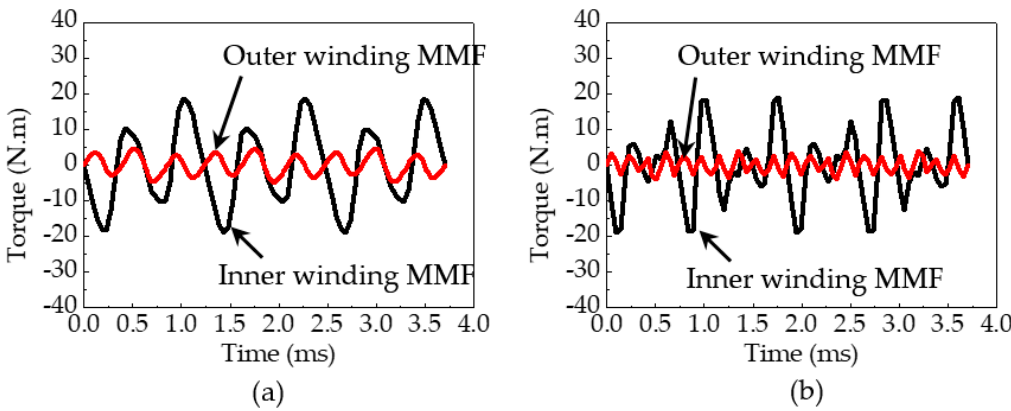
Figure 15. Cogging torque characteristics: ( a ) Cogging torques produced by the inner winding MMF ( f inner = 270 Hz) and the outer winding MMF ( f outer = 0 Hz), respectively, when the output rotor operated at 1246 rpm; ( b ) Cogging torques produced by the inner winding MMF ( f inner = 270 Hz) and the outer winding MMF ( f outer = 270 Hz), respectively, when the output rotor operated at 2492 rpm.